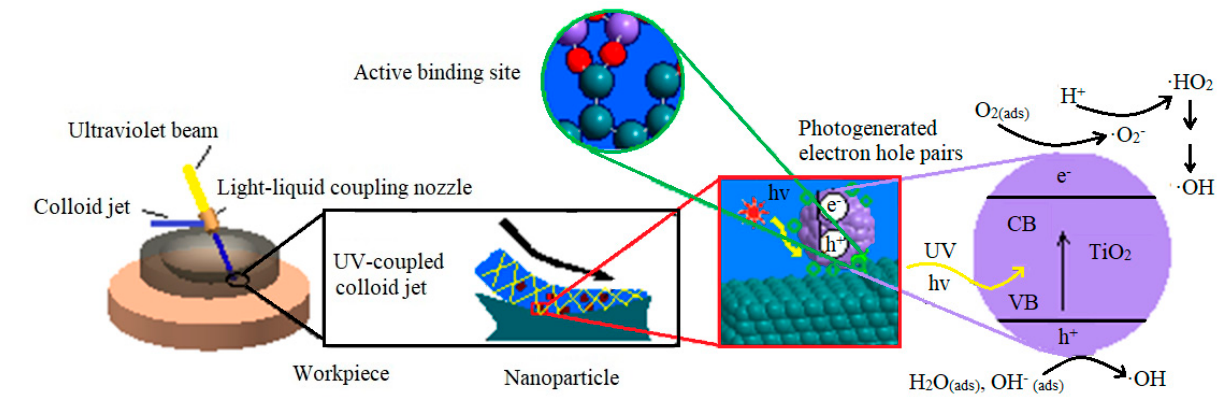
Figure 1. Schematic diagram of UV-induced nanoparticle colloid jet machining. In this work, the interactions of TiO 2 nanoparticles with a Si workpiece surface after nanoparticle colloid jet adsorption and UV-induced nanoparticle colloid jet adsorption are reported. The samples of the Si surface adsorbed by the TiO 2 nanoparticles under different adsorption conditions were fully characterized by SEM, XPS, and FT-IR. The photocatalysis effects of UV light were investigated in the adsorption and polishing